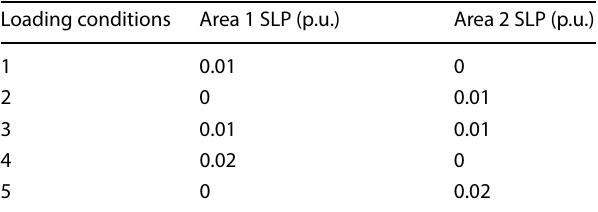
Table 1 Loading conditions for linear two-area system Loading conditions